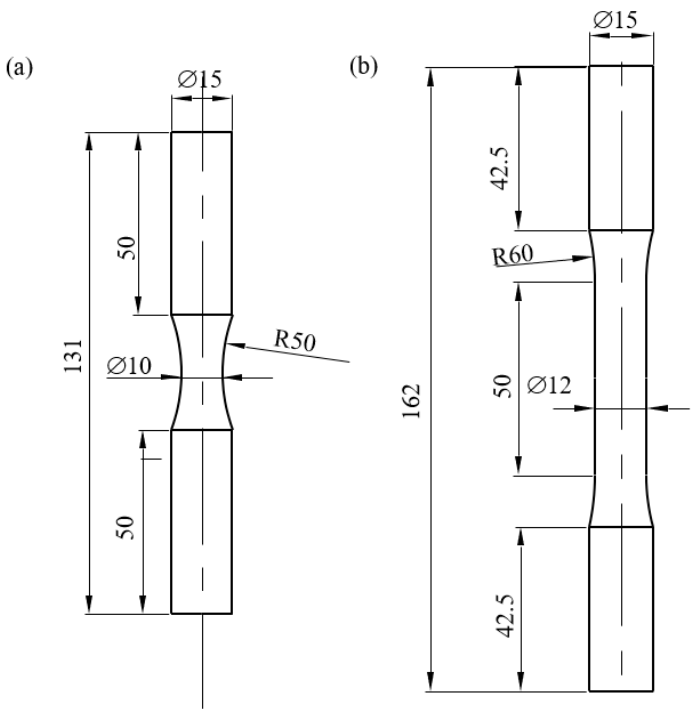
Figure 8. Specimen geometry for ( a ) staircase fatigue tests and ( b ) static- and step-load fatigue tests.